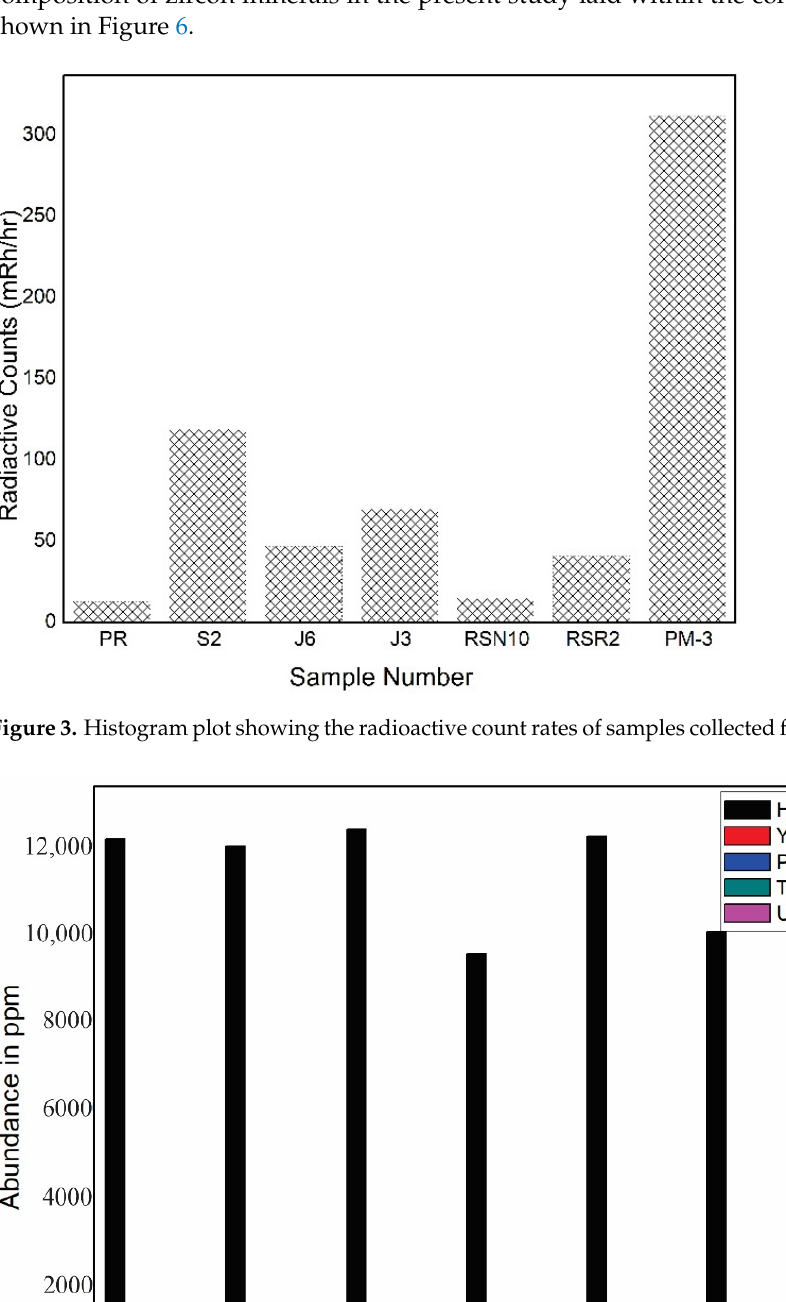
Figure 5. Abundance of REEs in zircon from different samples of sand.